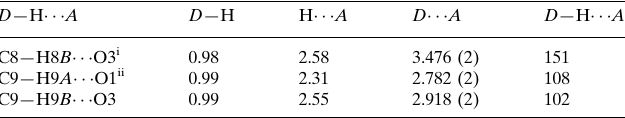
Hydrogen-bond geometry (A˚ , (cid:2)